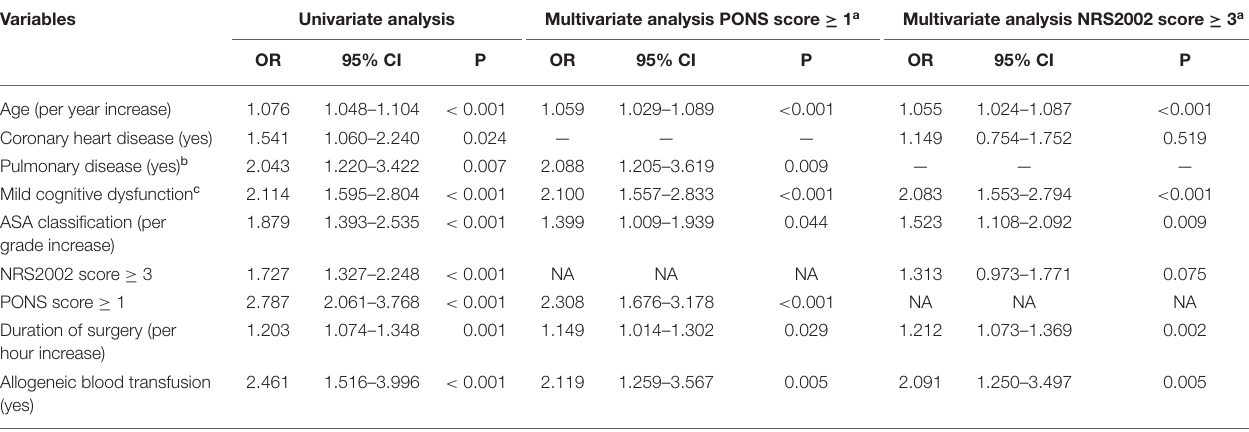
TABLE 4 | The relationship between PONS and postoperative